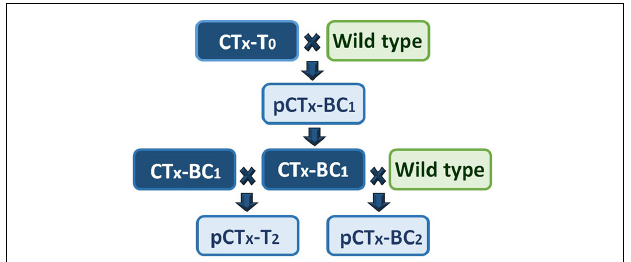
FIGURE 2 | A crossing scheme to generate the first and second generations of progeny. CTx refers to the 3 transgenic events (CTB, CTF, and CTG) used in crossing, T 0 is a primary transgenic event, BC 1 is a progeny of a backcross (BC) between primary transgenic and a wild-type (non-transformed) Mainstay white clover, BC 2 is the progeny of a backcross between BC 1 and wild-type clover, and T 2 is the progeny of a cross between two BC 1 individuals. pCTx refers to the progeny of a specified